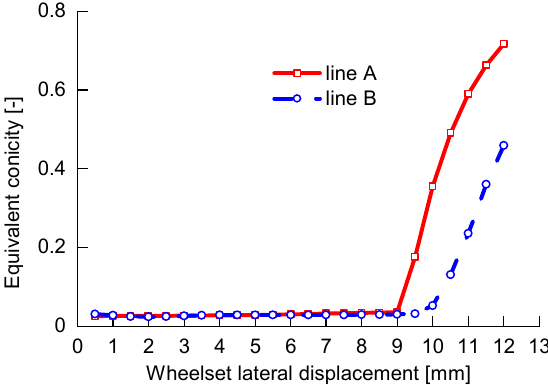
Figure 5. Equivalent conicity curves.